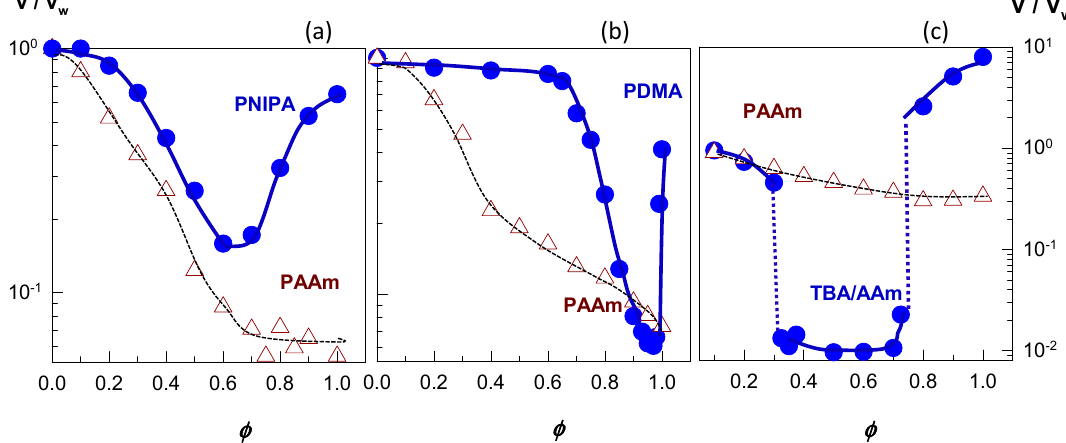
Figure 5. The swelling ratio V/V w of three hydrophobically modified hydrogels in water–cosolvent mixtures plotted against the volume fraction φ of the cosolvent (filled symbols). For comparison, the swelling behavior of nonionic PAAm is shown by the open symbols. ( a ) Nonionic PNIPA hydrogel in water–PEG-300 mixture. Adapted from [46] with permission from the Wiley VCH Verlag GmbH, Weinheim. ( b ) Nonionic PDMAA hydrogel in water–acetone mixture. From [49] with permission from the Elsevier Ltd. ( c ) Ionic TBA/AAm (60/40 by mole) copolymer hydrogel in water–DMSO mixture. From [52] with permission from the Elsevier